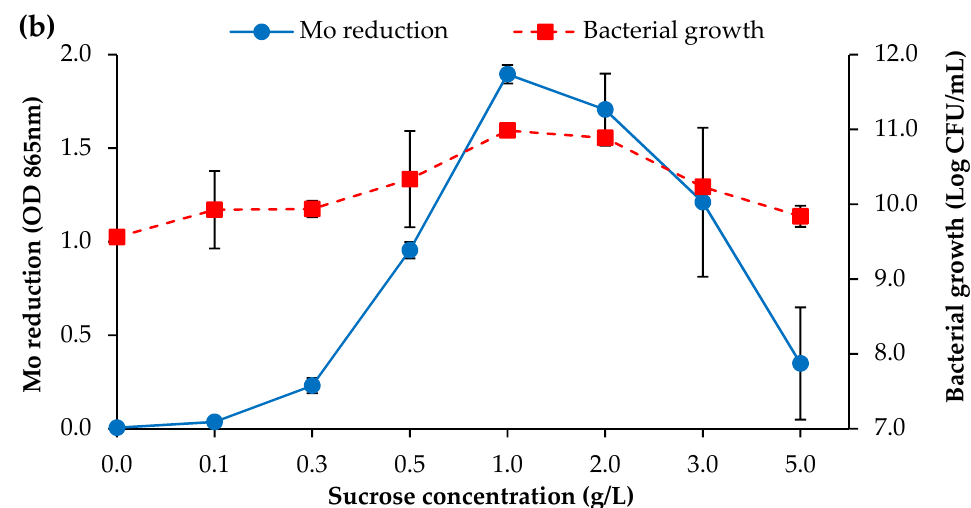
Figure 2. ( a ) The effects of various electron donors at the final concentration ( w / v ) of 1% on bacterial growth and Mo reduction; ( b ) The effects of different sucrose concentration on Mo reduction and growth of strain AQ5-05 in LPM after 168 h at 10 °C. The error bars represent the mean ± standard deviation for three replicates.